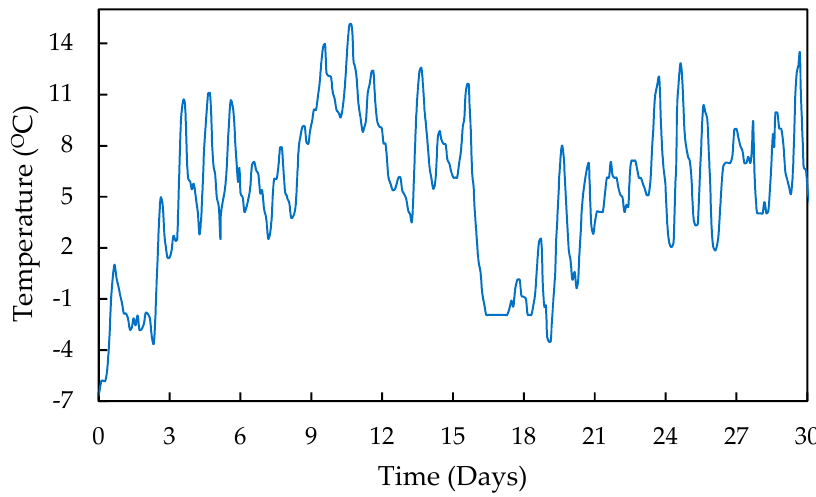
Figure 8. External varying temperature field.